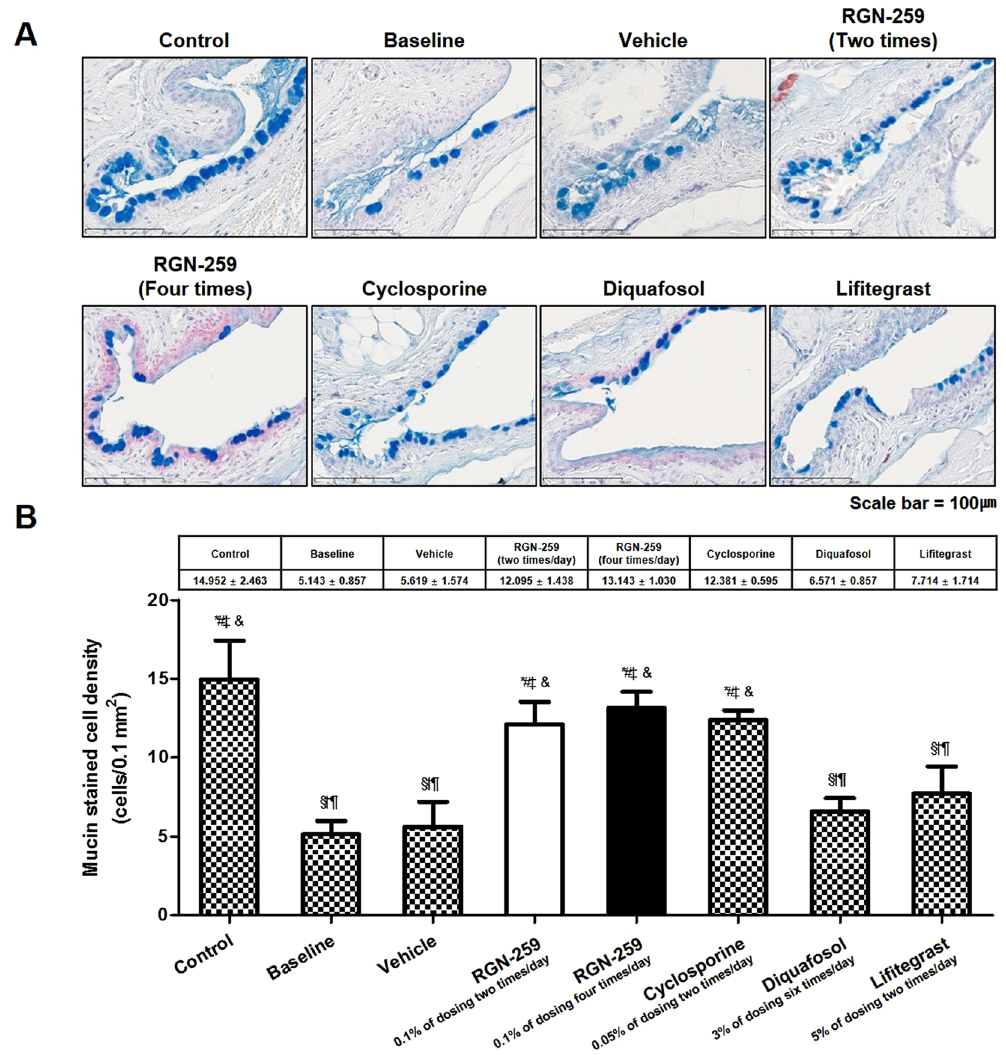
* P < 0.05 vs. the corresponding value in the baseline desiccation stressed group. # P < 0.05 vs. the value in the vehicle-treated group. § P < 0.05 vs. the value in the RGN-259, 2 times per day group. † P < 0.05 vs. the value in the RGN-259, 4 times per day group. ¶ P < 0.05 vs. the value in the CsA group. ‡ P < 0.05 vs. the value in the DQSl group. & P < 0.05 vs. the value in the LFA